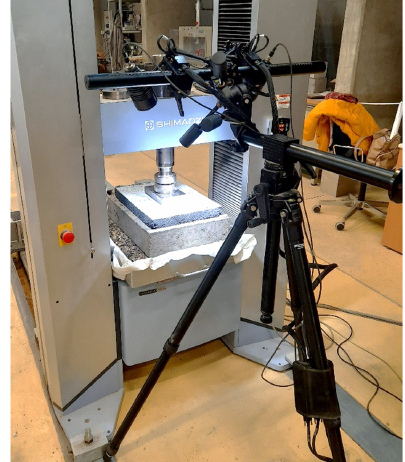
Figure 2. Pavement structure test setup.